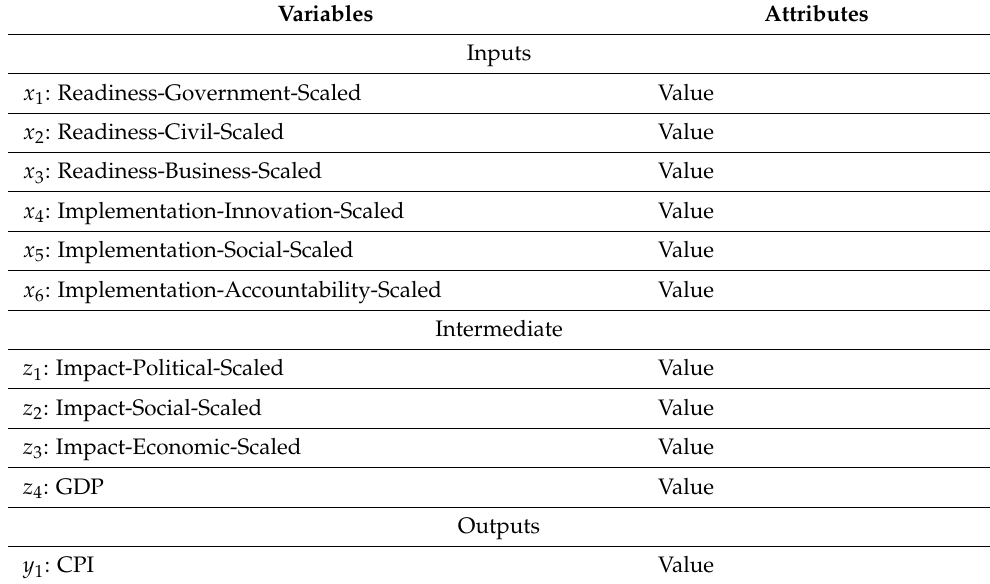
Table 4. Datasets.